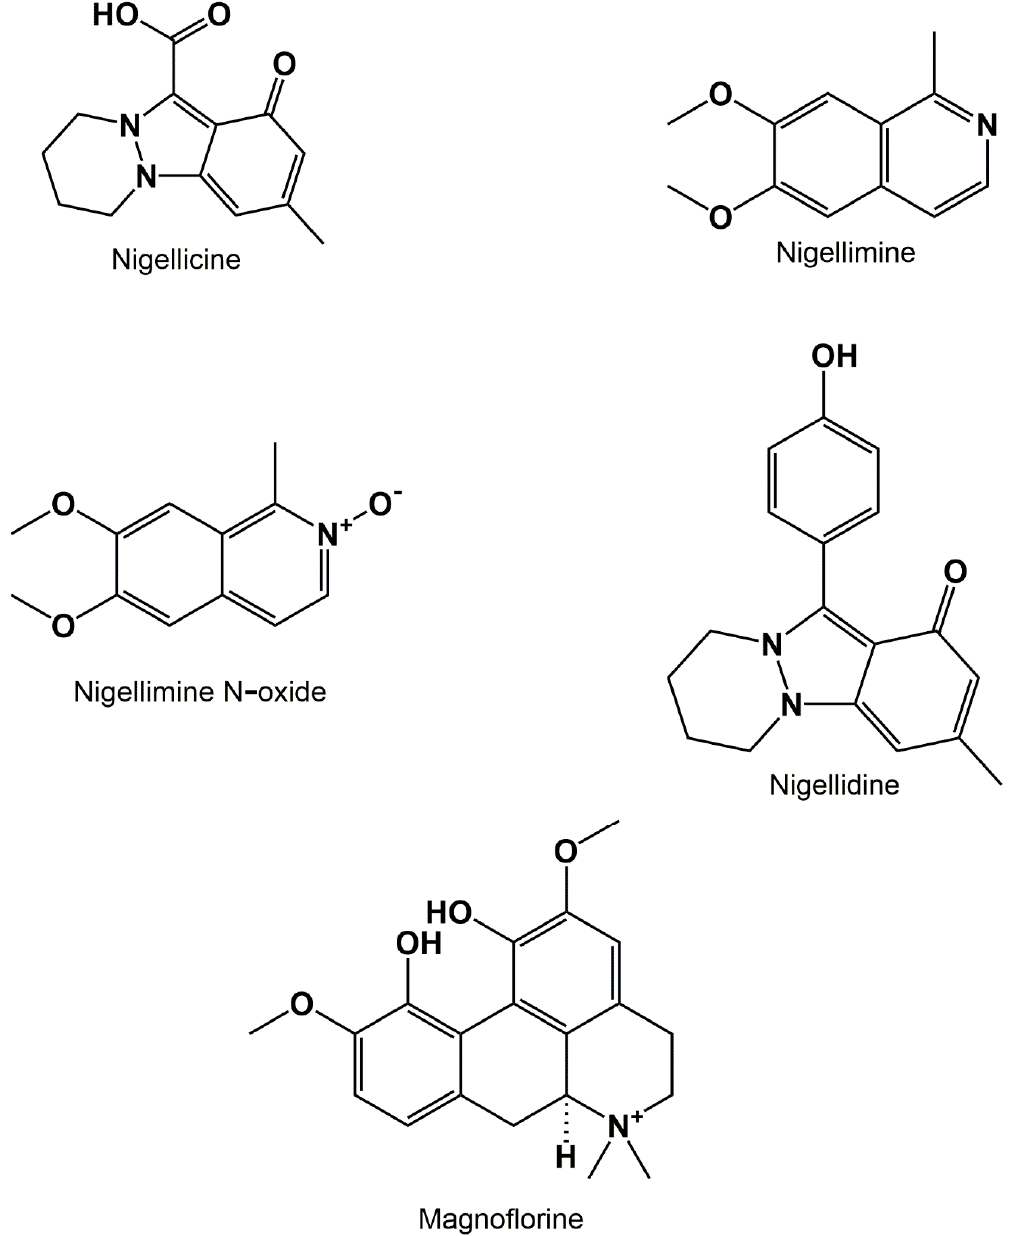
Figure 3. Nigella sativa isolated and identified alkaloids.